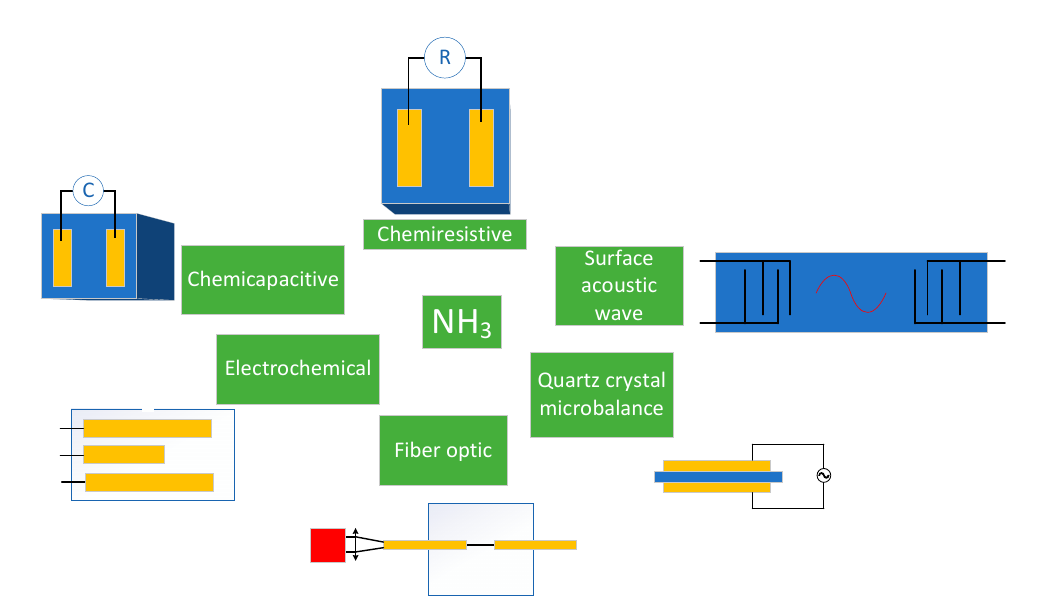
Figure 1. Different types of ammonia gas sensors.